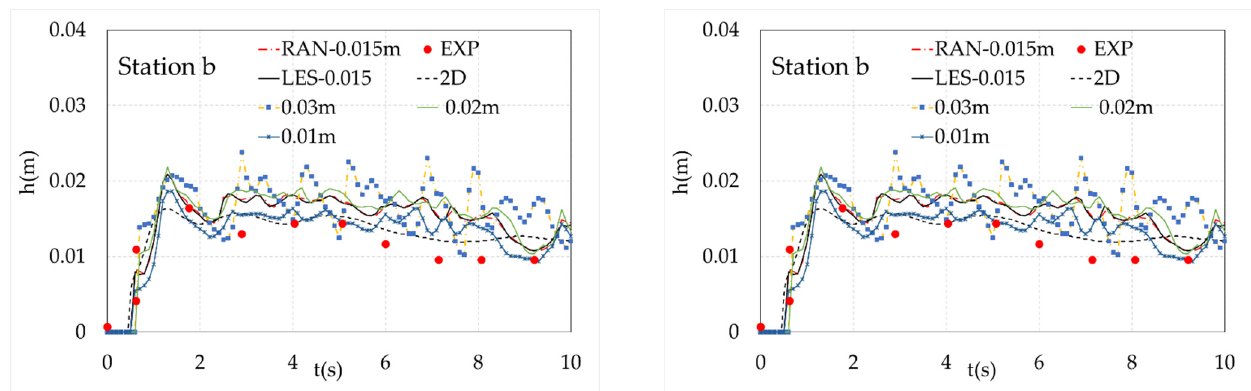
Figure 4. Water depth and u -velocity profiles at gauge b.